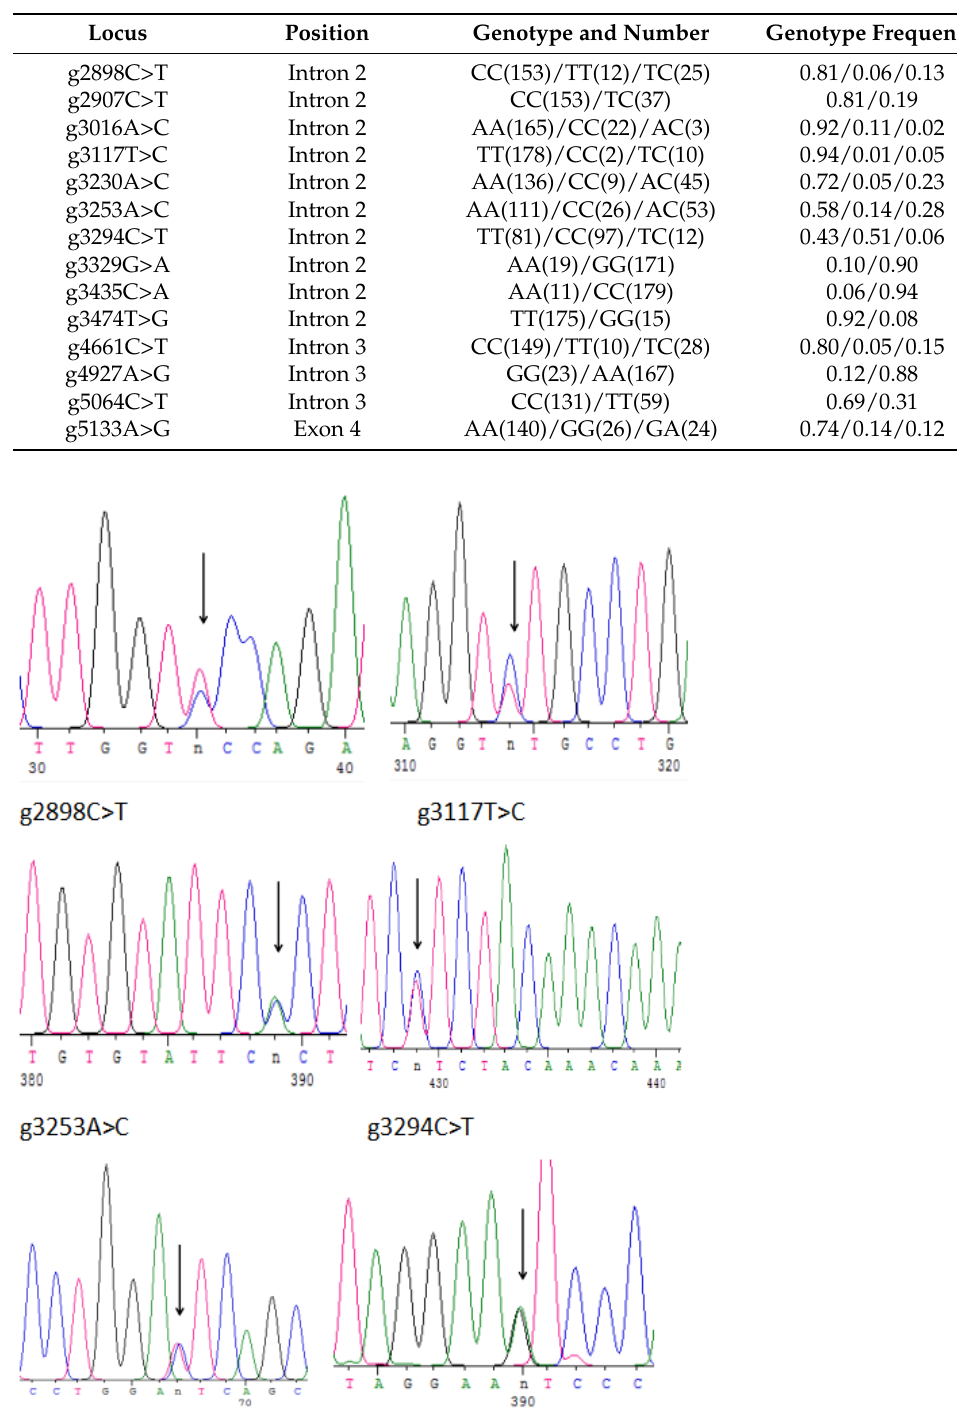
Table 3. Fourteen SNP alleles and genotype frequency of igf2 .